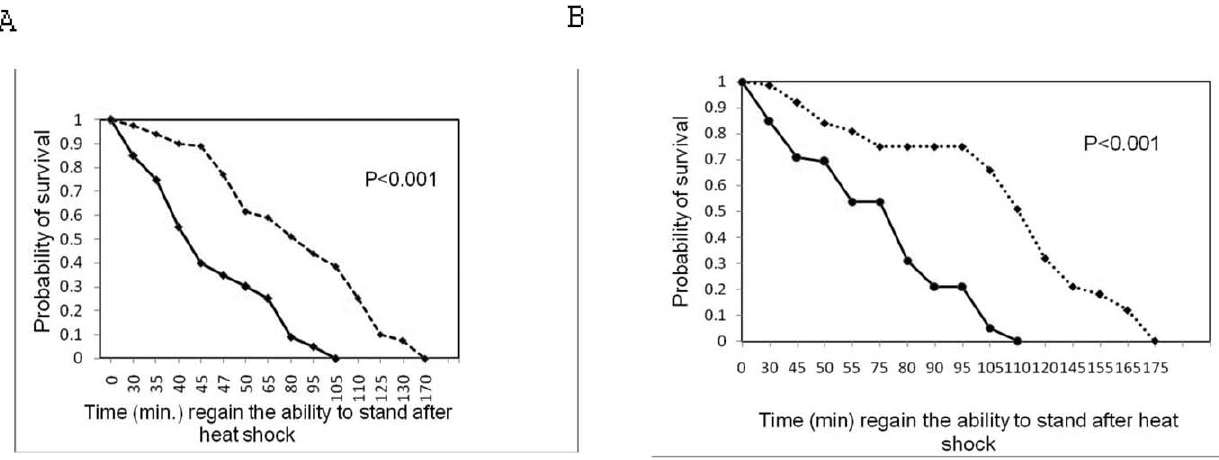
Figure 4. Survival curves for heat – shock in males (A) and females (B) derived from either protein (–) or carbohydrate (- - -) enriched medium.